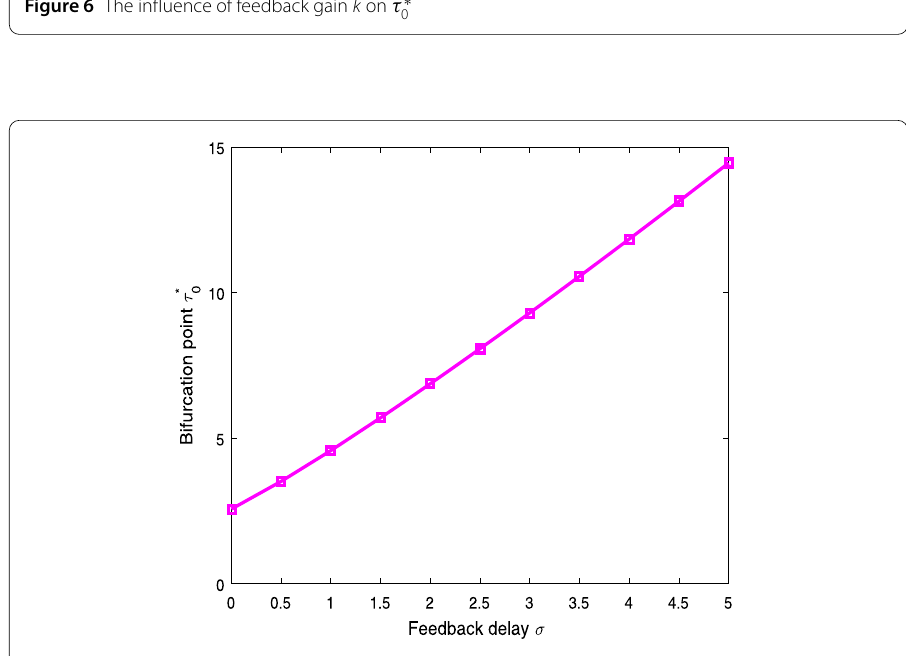
Figure 7 The impact of feedback delay σ on τ ∗